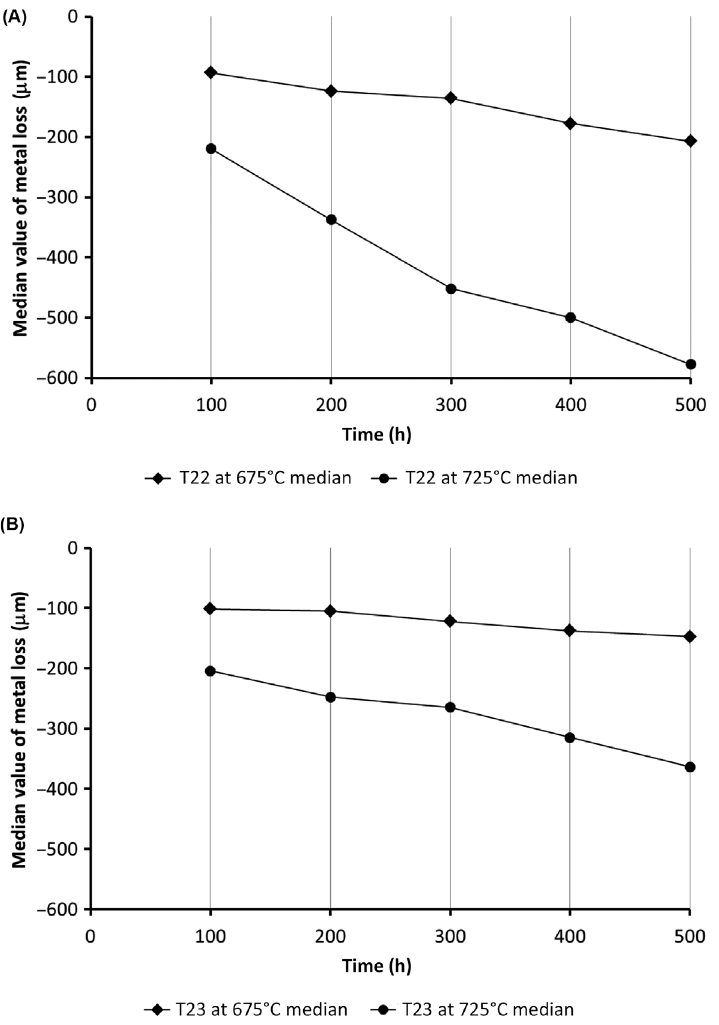
Figure 9: Median values of metal loss of T22 and T23 materials for 500 h at 650°C (A) and 725°C